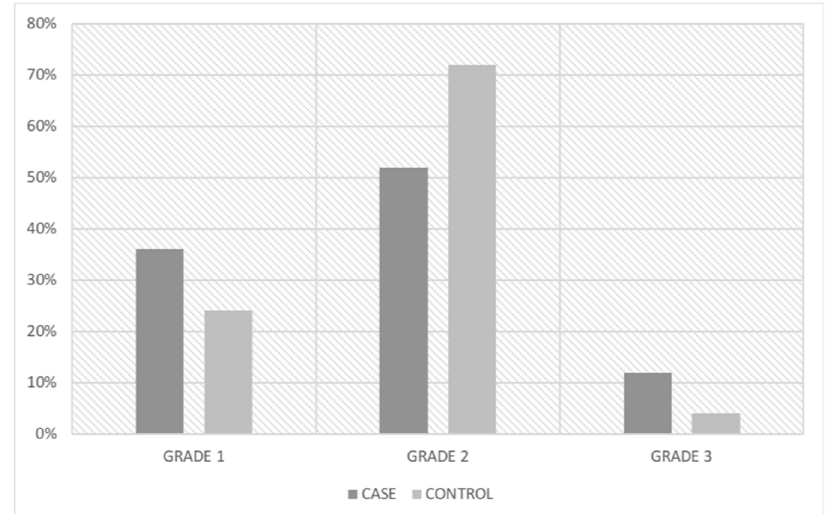
Figure 3 - Qualitative assessment of mandibular cortical bone erosion in childhood HSCT patients and healthy controls by the Klemetti index (%).